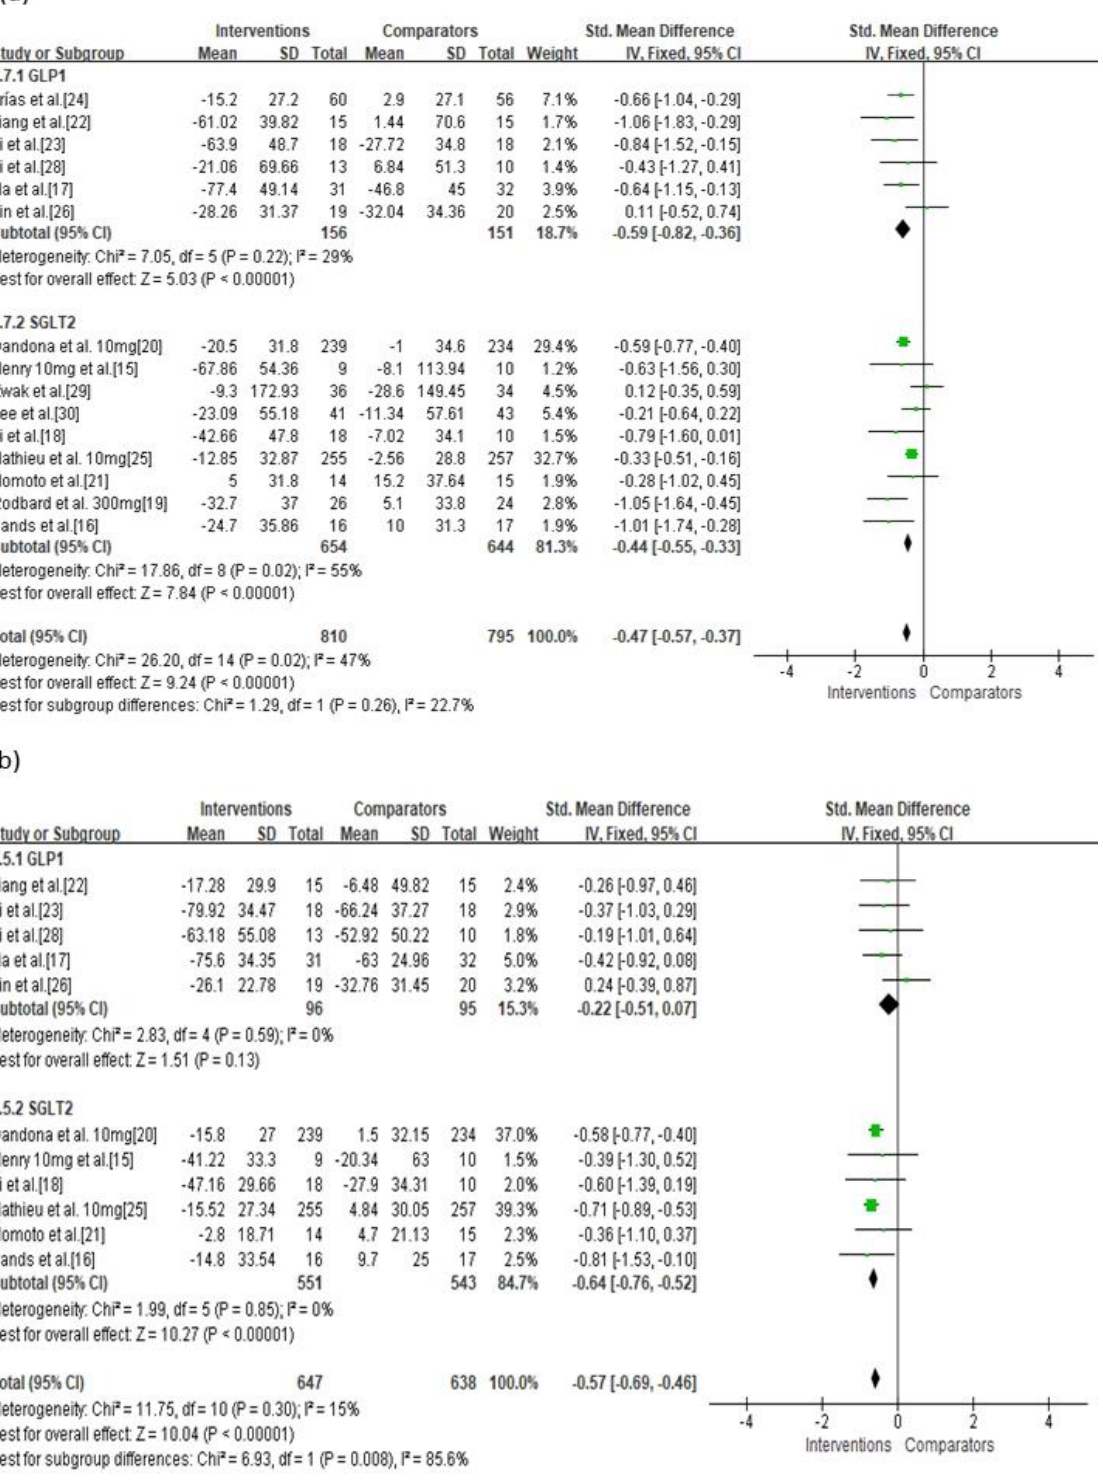
Figure 7. Effects of intervention on MAGE and MBG levels according to fixed mono-dosage of SGLT-2 inhibitors or GLP-1 agonists. ( a ) MAGE; ( b ) MBG level. MAGE, mean amplitude of glycemic excursion; MBG, mean blood glucose; GLP-1, glucagon-like peptide 1; SGLT-2, sodium-glucose cotransporter 2. Green squares suggested measure of effect for each of included studies, and black diamond represented as meta-analyzed measure of effect. Bold letters indicated a category or subtotal of each subgroup and overall outcome.